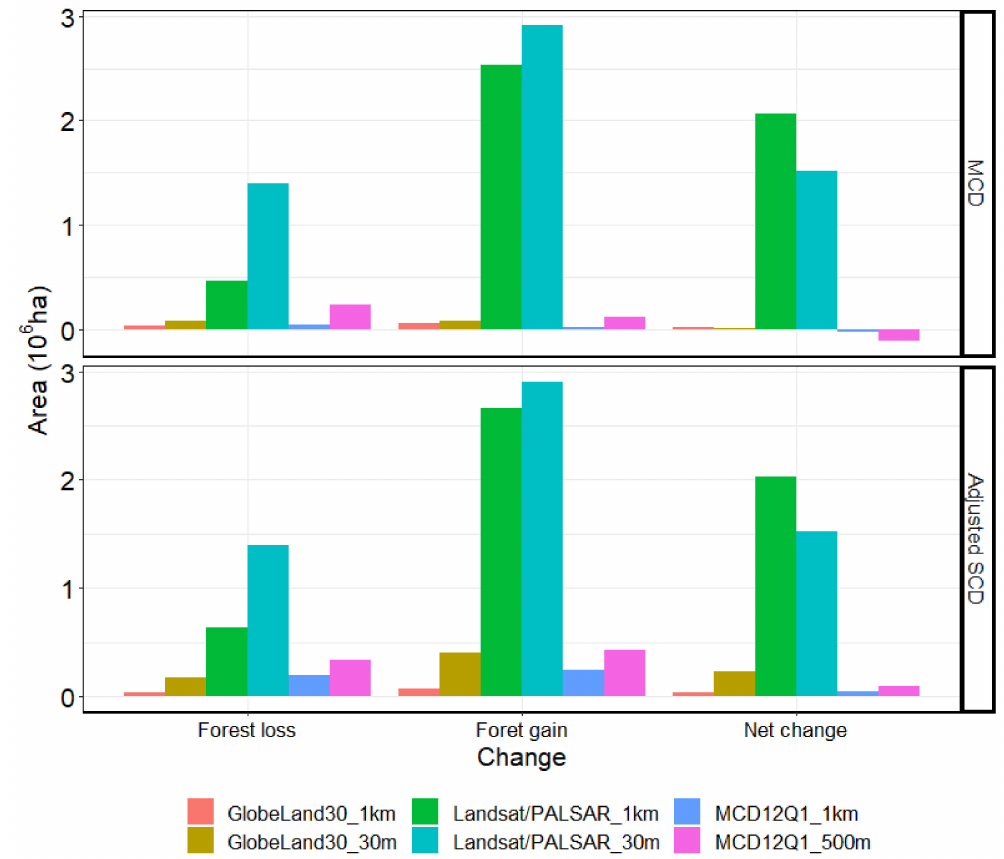
Figure 5. Areas of forest gain, loss, and net change in Guangdong, China from